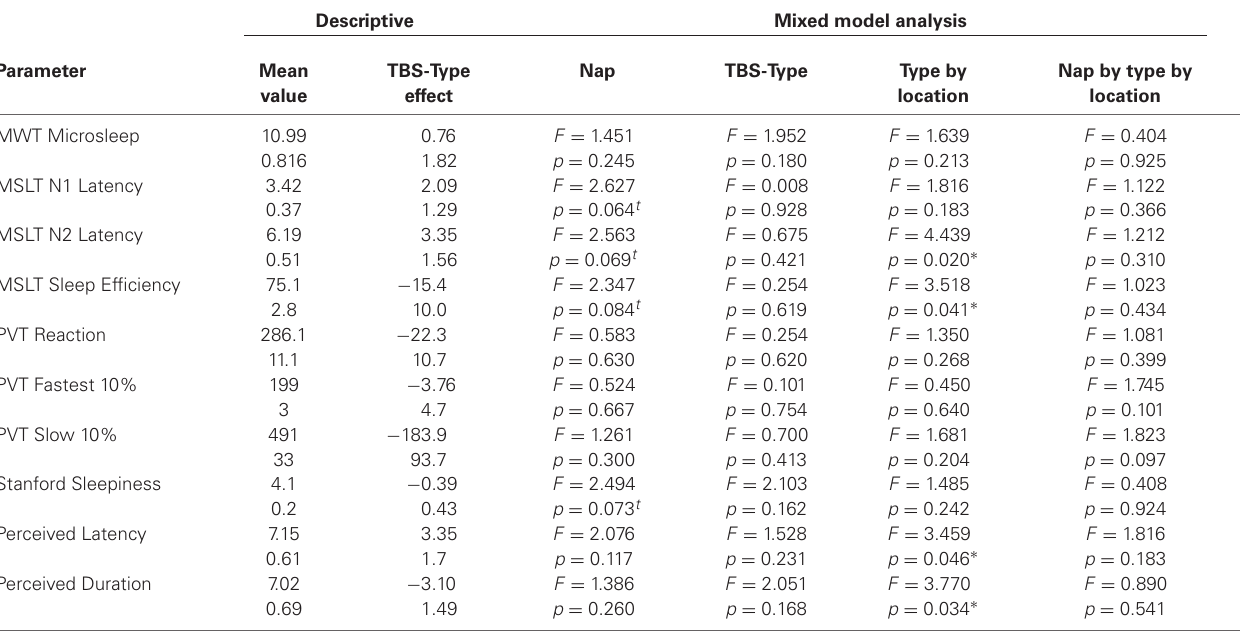
Table 2 | Statistical overview: effects of stimulation for each measured parameter .